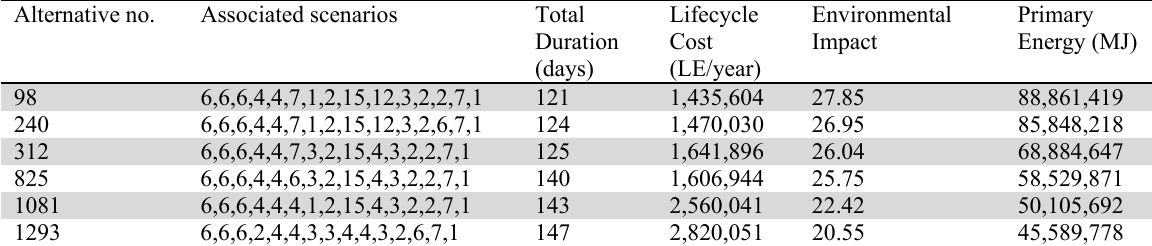
Fig. 4. Generated solutions from the optimization module Table 3 Sample of optimal solutions Alternative